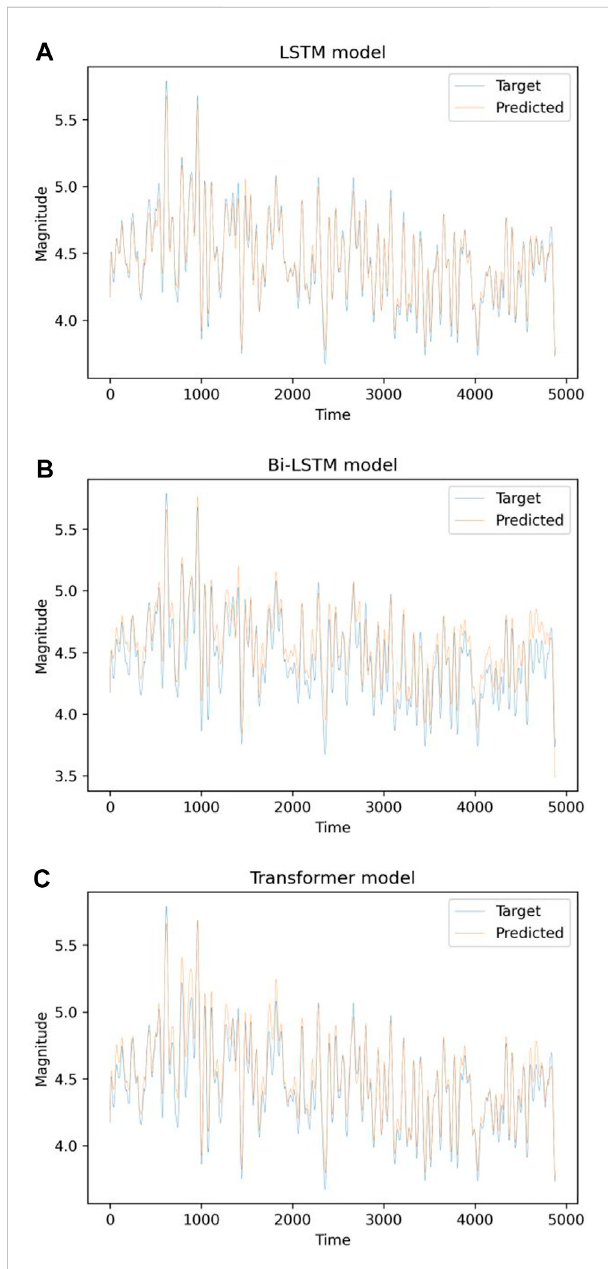
FIGURE 10 Plot of projected and actual magnitude as a function of time for the Indonesia earthquake catalogue using the (A) LSTM, (B) Bi-LSTM, and (C) transformer